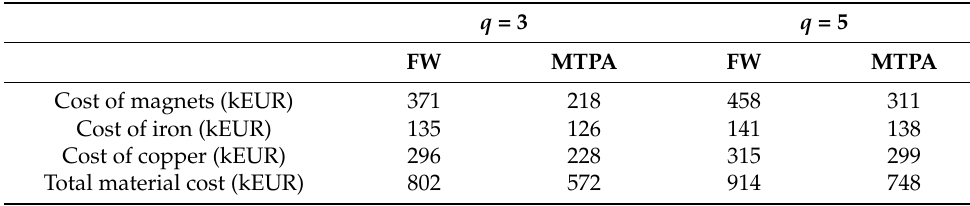
Table 4. Cost of the optimal solutions.